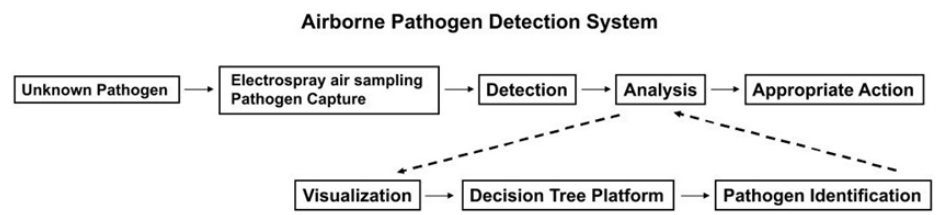
Figure 1. A strategy for an airborne detection system that couples air sampling, pathogen capture, and analysis via visualization technologies and decision analysis platforms.